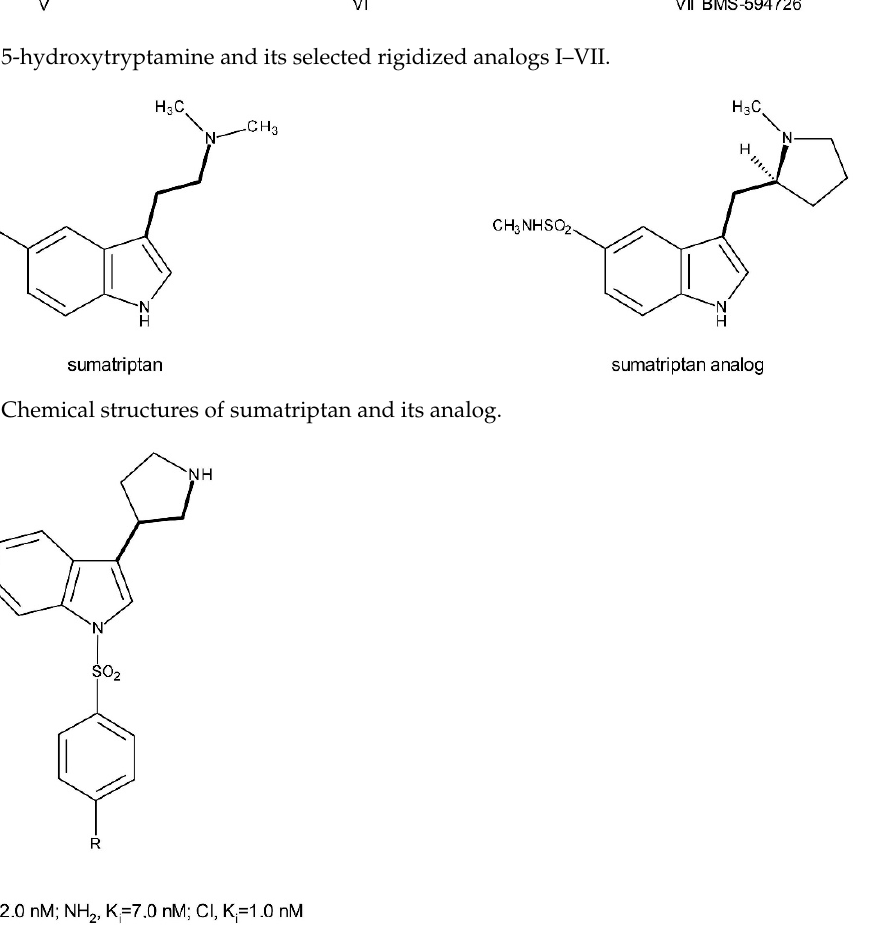
Figure 1. 5-hydroxytryptamine and its selected rigidized analogs I–VII.